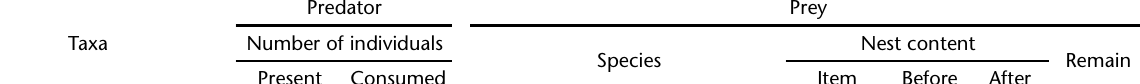
Table I. Predator species, number present during the predation event (present), and items consumed at the nest; prey species, type of item in the nest (egg or nestling), number of items in the nest before and after predation and evidences left by the predator recorded in each predation observed in Brazilian central Cerrado. Sistematic order after C BRO